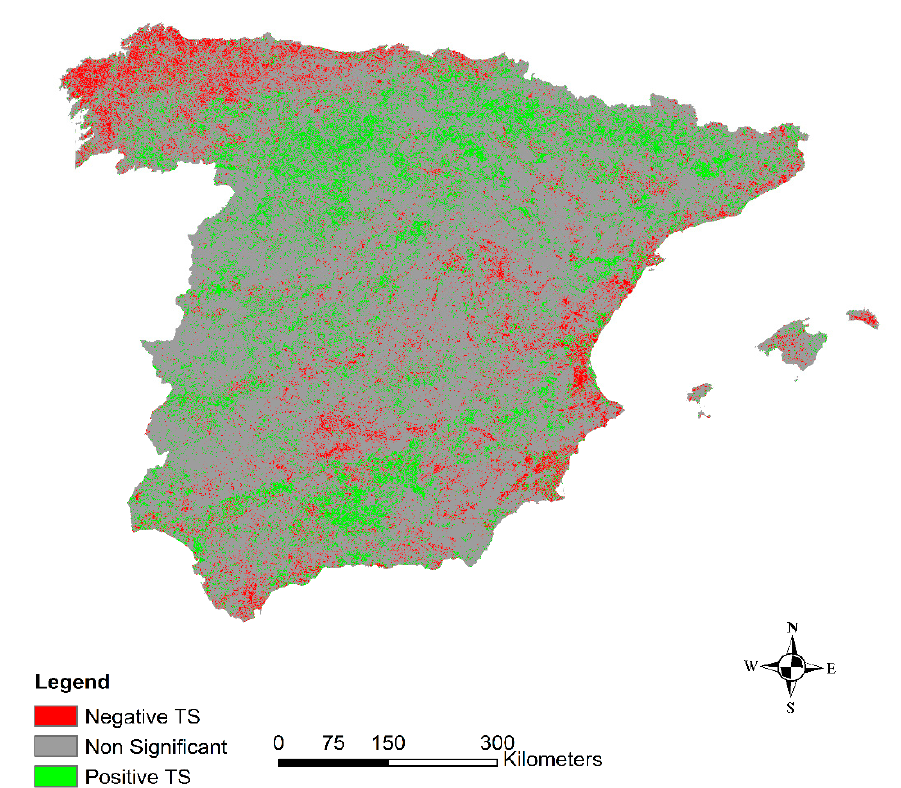
Figure 5. Spatial pattern that resulted from intersecting the Theil–Sen slopes with the Mann–Kendall test ( z -statistic), testing annual averages from 2001–2016 Moderate Resolution Imaging Spectroradiometer ( MODIS) normalized difference vegetation index (NDVI) values. The red color shows the pixels with negative Theil–Sen slopes and a Mann–Kendall z -statistic below 0.1 (significant trend). The green color shows the pixels with positive Theil–Sen slopes and a Mann–Kendall z -statistic below 0.1 (significant trend). Finally, the black color shows the pixels with a Mann–Kendall z -statistic higher than 0.1 (non-significant